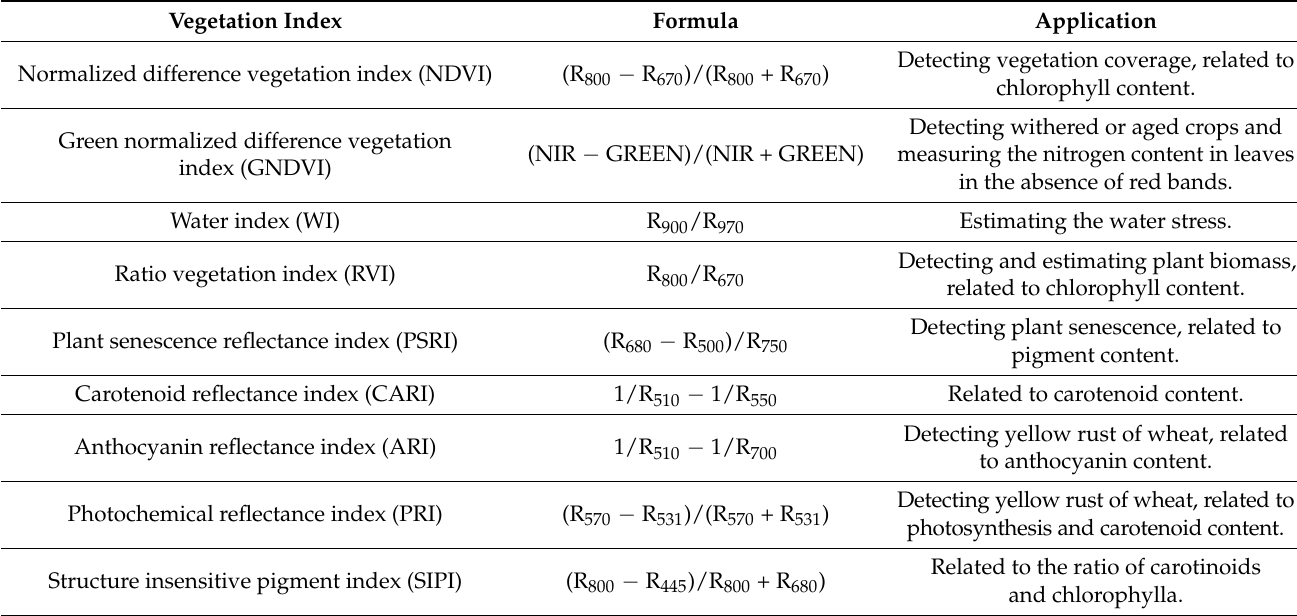
Table 1. Application of general spectral vegetation